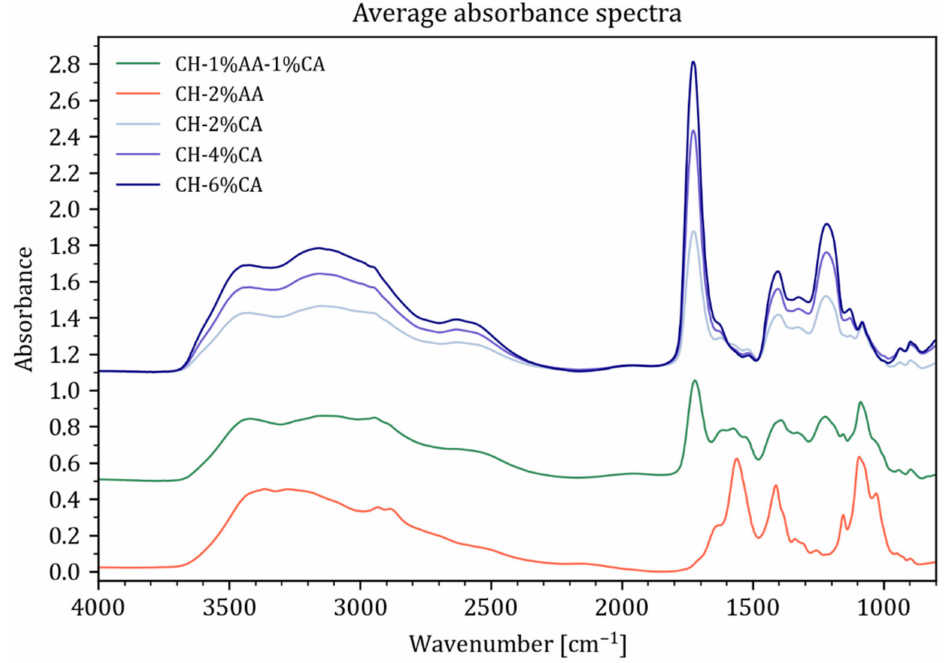
Figure 1. Dry-film transmission FTIR spectra of the chitosan films prepared using acetic acid (2% v / v ), a combination of acetic acid (1% v / v ) and citric acid (1% w / v ), and citric acid (2, 4, and 6% w / v